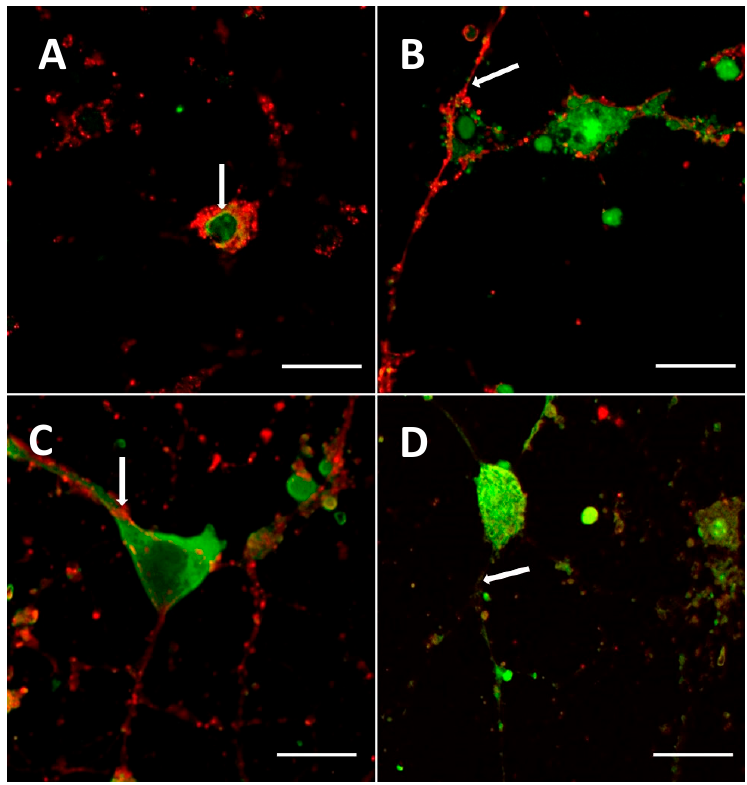
Figure 5. Confocal images showing cellular uptake of ( A ) G1-NH 2 ; ( B ) G1-90/10; ( C ) G4-NH 2 ; and ( D ) G4-90/10 dendrimers by the primary cortical culture (neurons and glial cells). Co-localization between the cellular stain (red) and the FITC labeled dendrimers (green) were observed. The processes of the neurons were also able to uptake the dendrimer (arrow; A – D ). All images were taken at 60× (2.5× zoomed in) magnification using Olympus BX50 Upright Microscope (Olympus, Shinjuku, Tokyo, Japan). Scale bar: 20 μ m.